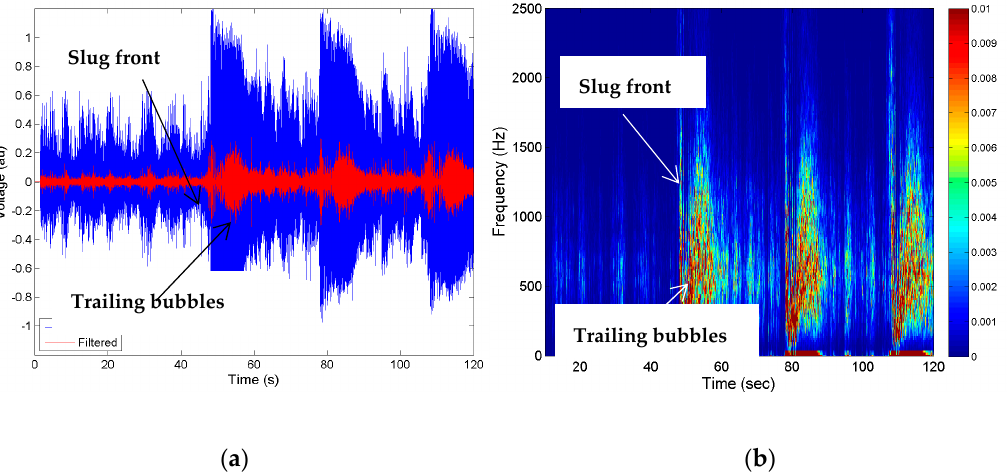
Figure 6. The analysis methodology ( a ) raw Doppler signal (blue) and bandpass-filtered signal 0.95–1.05 kHz (red); ( b ) spectrogram image using short-term Fourier transform (STFT).